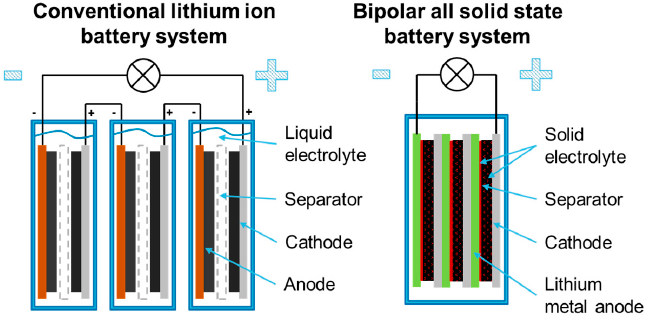
Figure 2. Schematic construction of a conventional and a bipolar lithium ion battery.